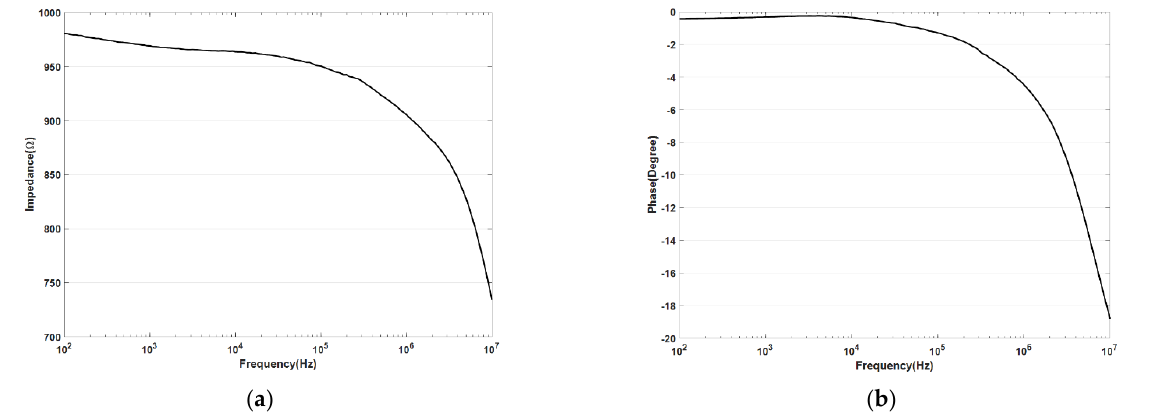
Figure 2. For the sensor not including glycerin: ( a ) Impedance amplitude versus frequency relation and ( b ) Phase angle versus frequency relation .